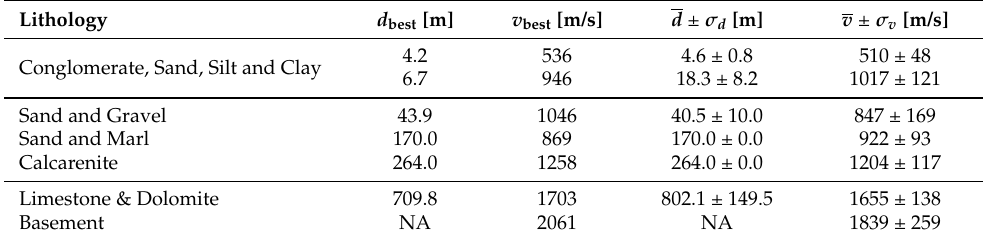
Table 3. Well-log lithology and HVSR inversion final Vs models from the EJDN station are summa- rized for data obtained by MEMD. The best model (depth, d best , and Vs, v best ), and the mean model with standard deviation (depth, d ± σ d , and Vs, v ± σ v ) are displayed.